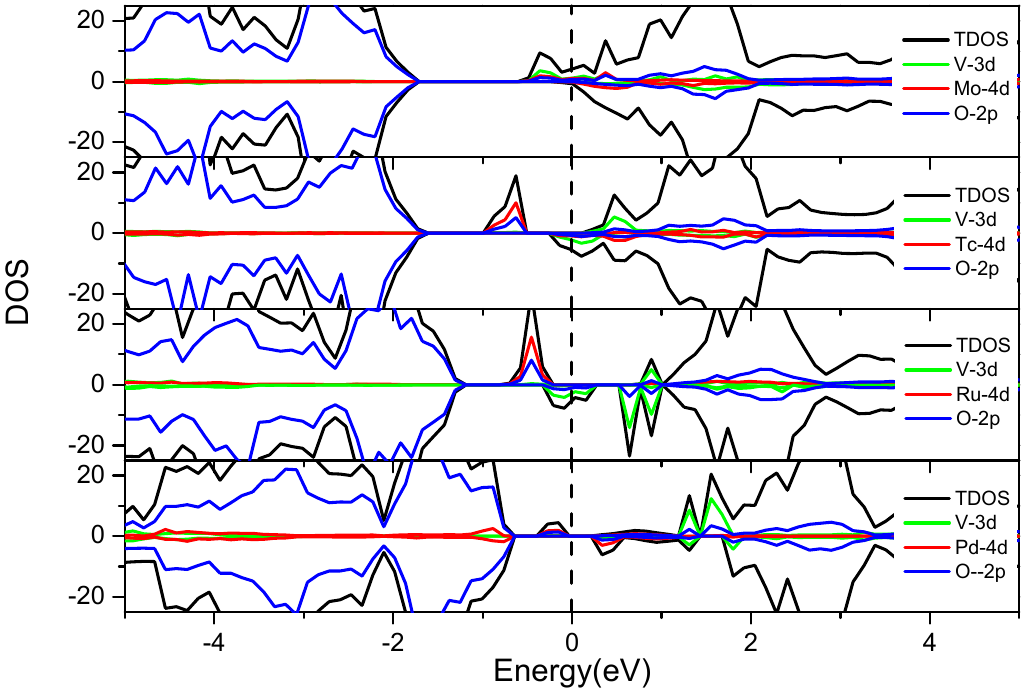
Figure 6. The total and partial density of states of the V-M ″ (4d metal elements: Mo, Tc, Ru and Pd) co-doped BaTiO 3 . The black dashed line indicates the position of the Fermi level.